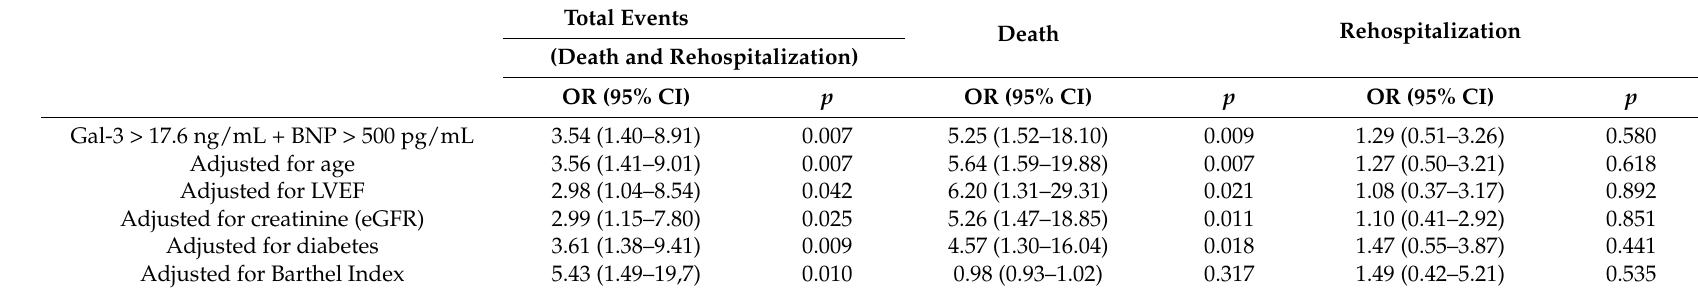
Table 4. Logistic regression: Galectin-3 > 17.6 ng/mL + BNP > 500